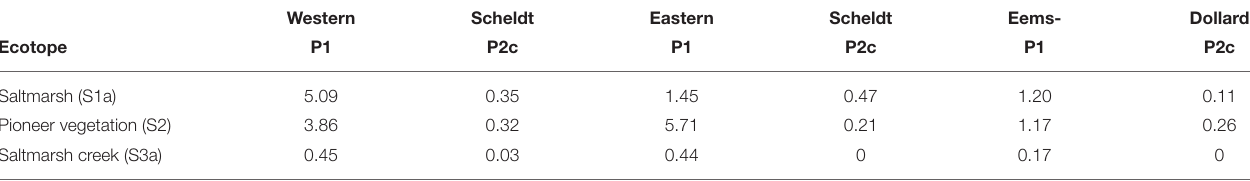
TABLE 3 | Normalized lengths of transitions between saltmarsh (rows) and tidal flat (columns) for the three systems. Western